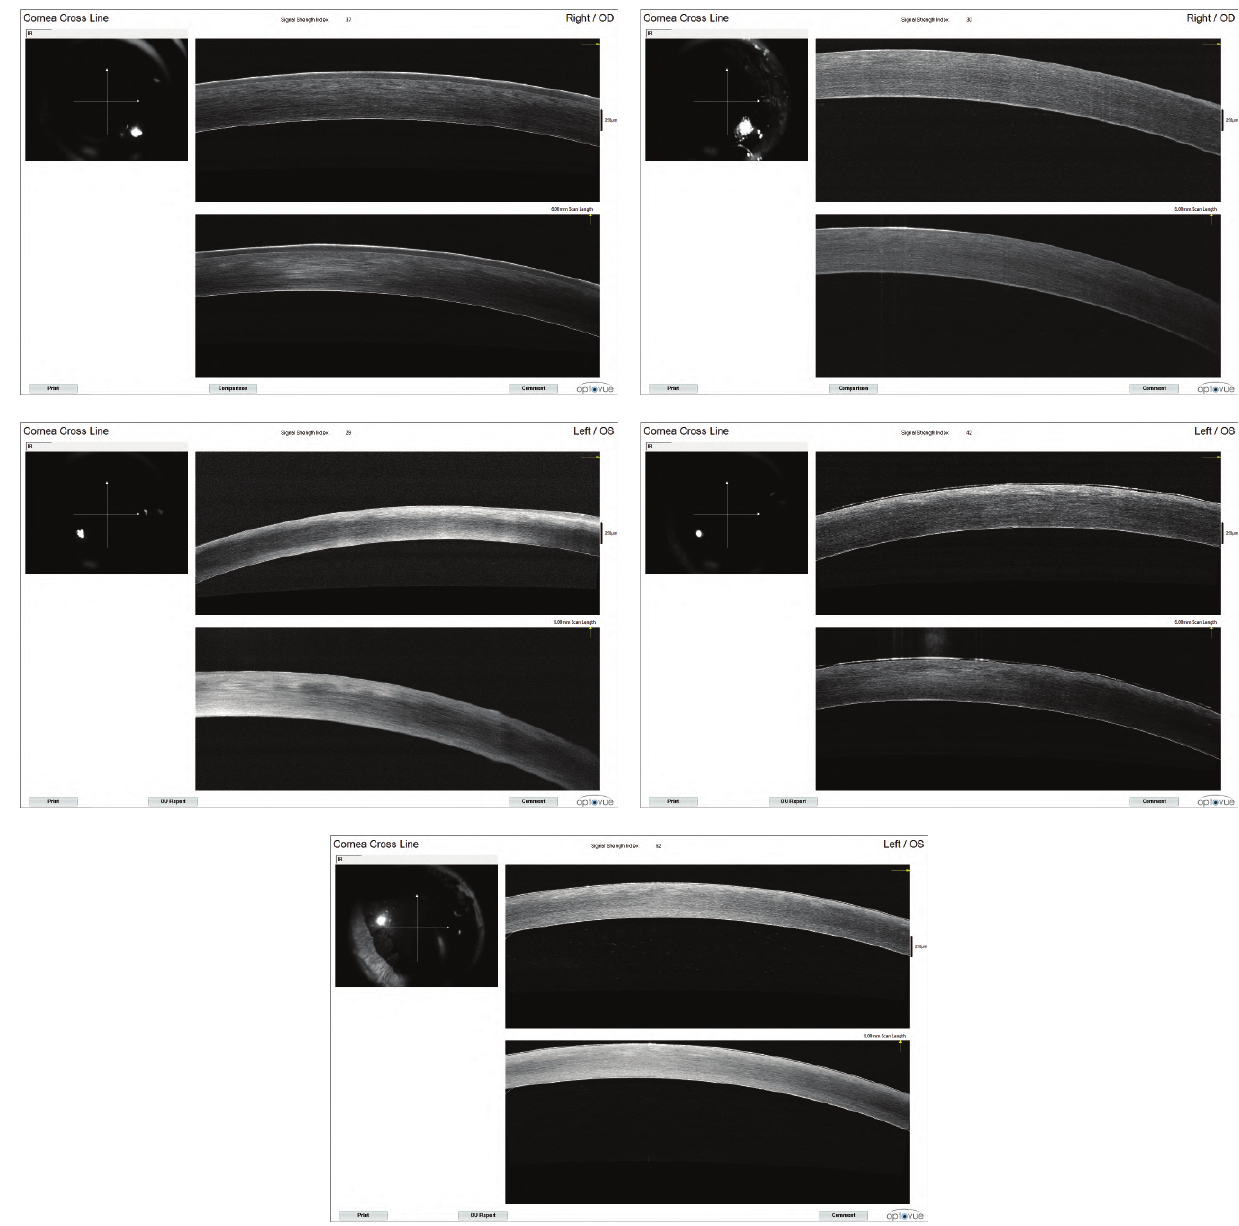
Figure 1. Optical Coherence Tomography corneal images of the groups control (a), sham (b), ozone (c), cross-linking (d), ozone- cross-linking (e), respectively. Hyperreflectivity is increased in anterior stroma in groups X and Z, but generalized in